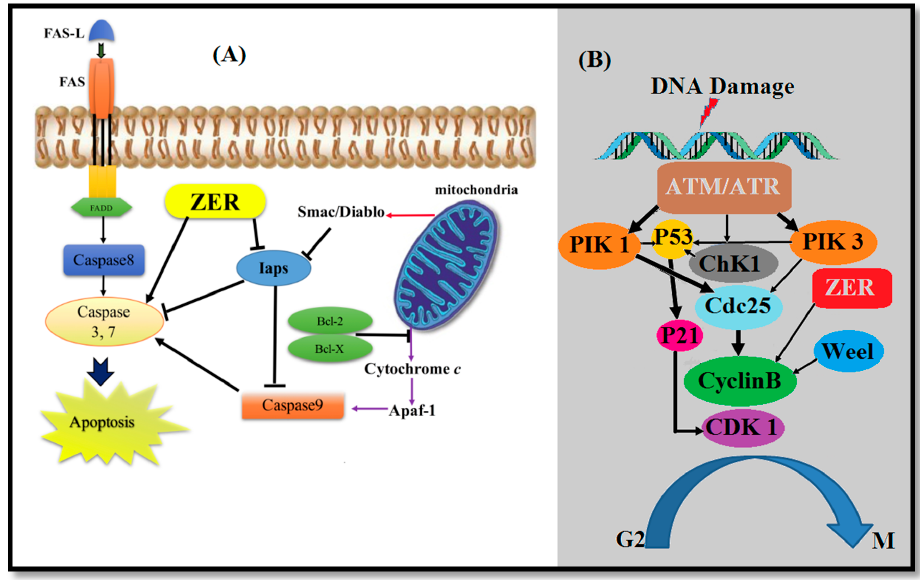
Figure 6. Proposed signaling pathways of ZER-induced apoptosis in cancerous cells ( A ). The cytotoxicity effects of ZER on leukemia cells through cell cycle arrest ( B